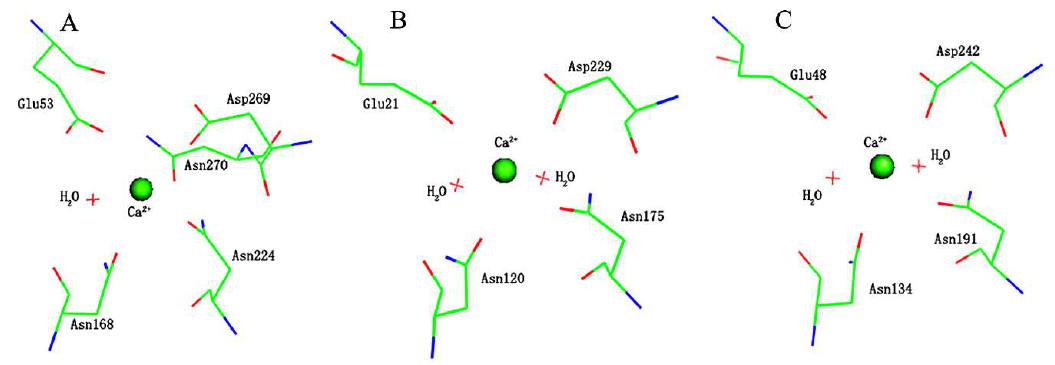
Figure 2. Active site structures of PON1 (PDB code: 3SRE) [15] ( A ), DFPase (PDB code: 2GVW) [18] ( B ) and XC5397 (PDB code: 3DR2) [28] ( C ), respectively. These figures are drawn by the PyMOL [44].